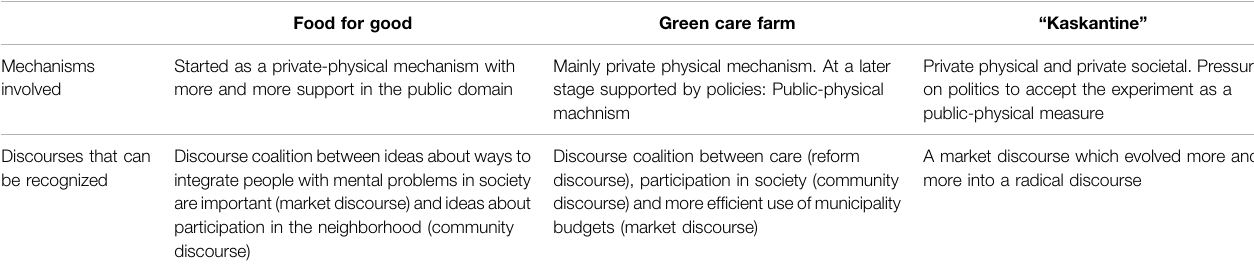
TABLE 4 | Mechanisms and discourses in three